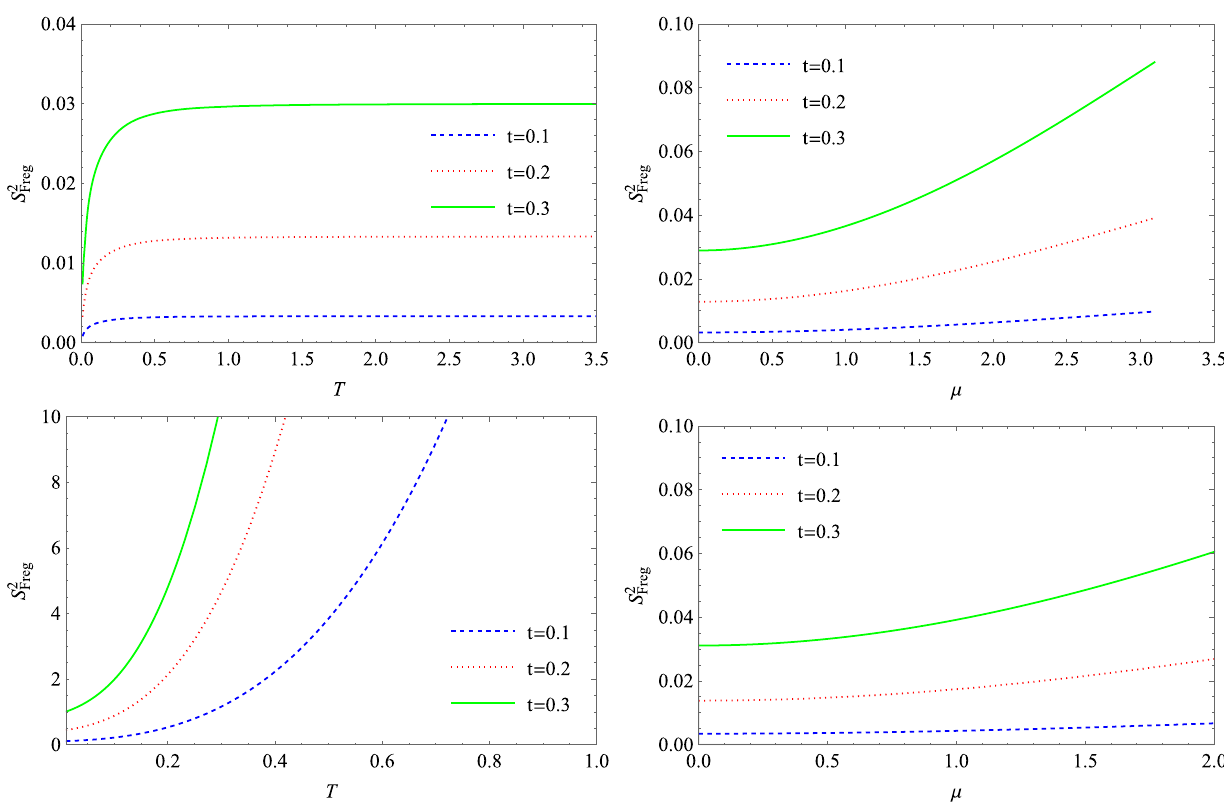
Fig. 7 Fermionic regularized mean square displacement s 2 as a function of the temperature T or the chemical potential μ for the short time Freg approximation, Eq.(75), for some values of the time t . Upper panels: positive fixed value of k . Lower panels: negative fixed value of k